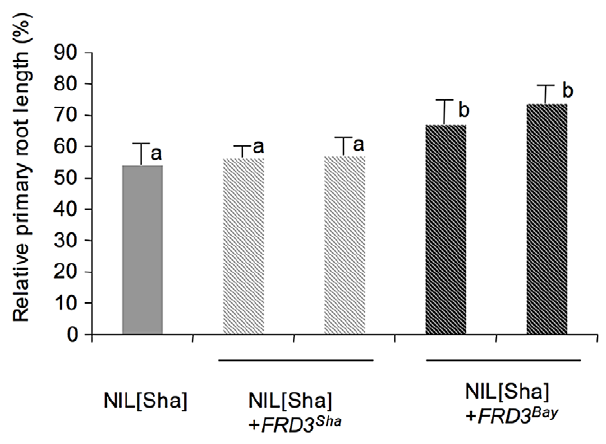
Figure 2. Functional complementation. Relative primary root lengths are shown for NIL[Sha] plants and for transgenic NIL[Sha] plants expressing either the FRD3 Bay or the FRD3 Sha allele. Relative primary root length is the primary root length of plants grown at 150 m M Zn as a percentage of the primary root length of plants grown at 1 m M Zn. Error bars represent confidence intervals calculated after logarithmic transformation of data [41] (P , 0.05; n=7 to 21). Similar increased relative root lengths were observed in 2 additional independent NIL[Sha] lines complemented with FRD3 Bay (data not shown).